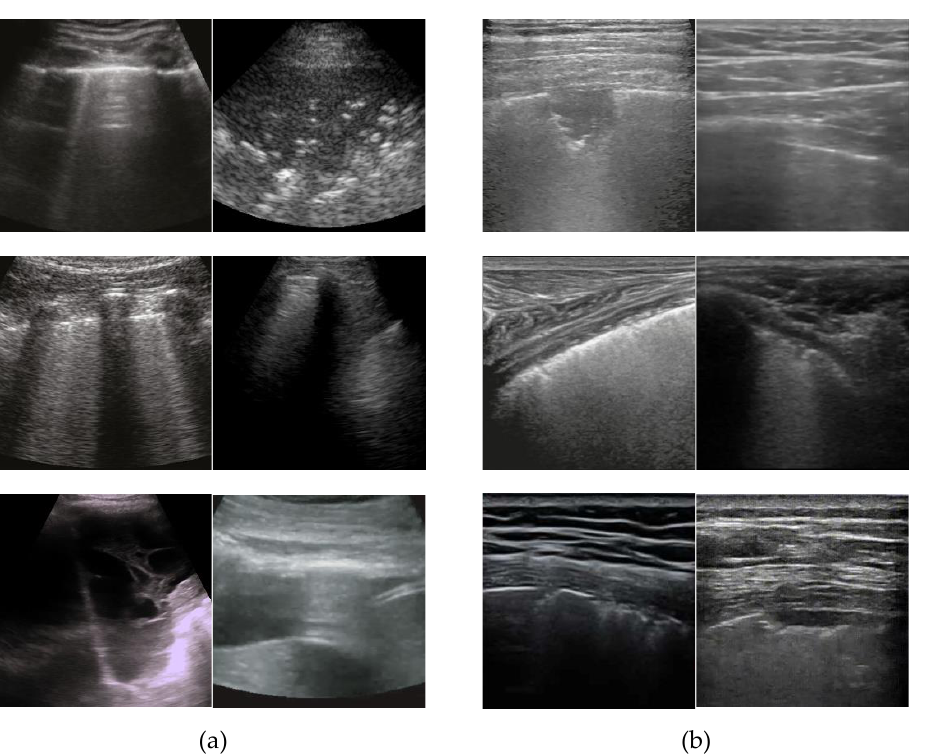
Figure 1. Examples of ultrasound images obtained from different probes and records using ( a ) a convex sensor and ( b ) a linear sensor.